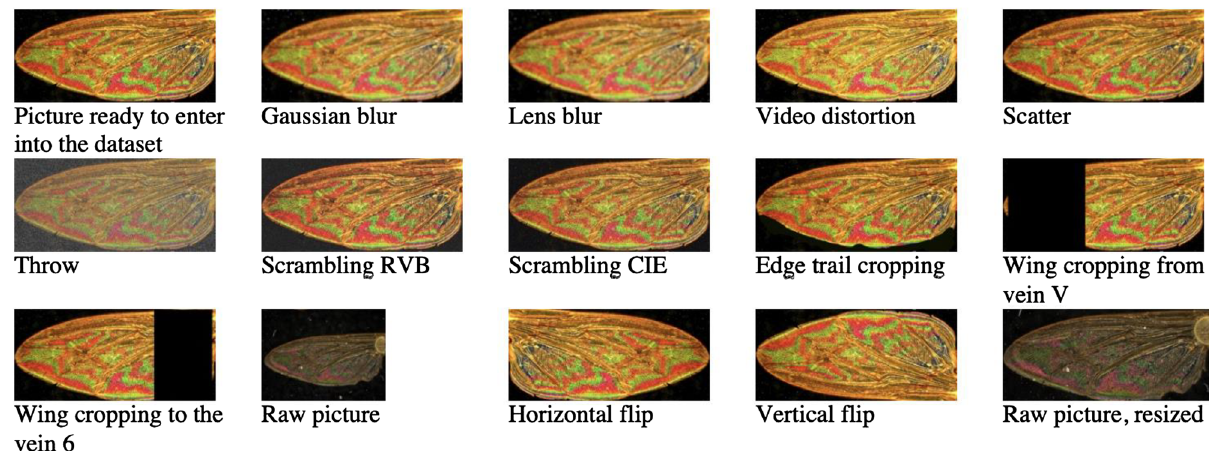
Figure 4. Examples of WIPs pictures ( G. pallidipes ) after manual or computer transformations.